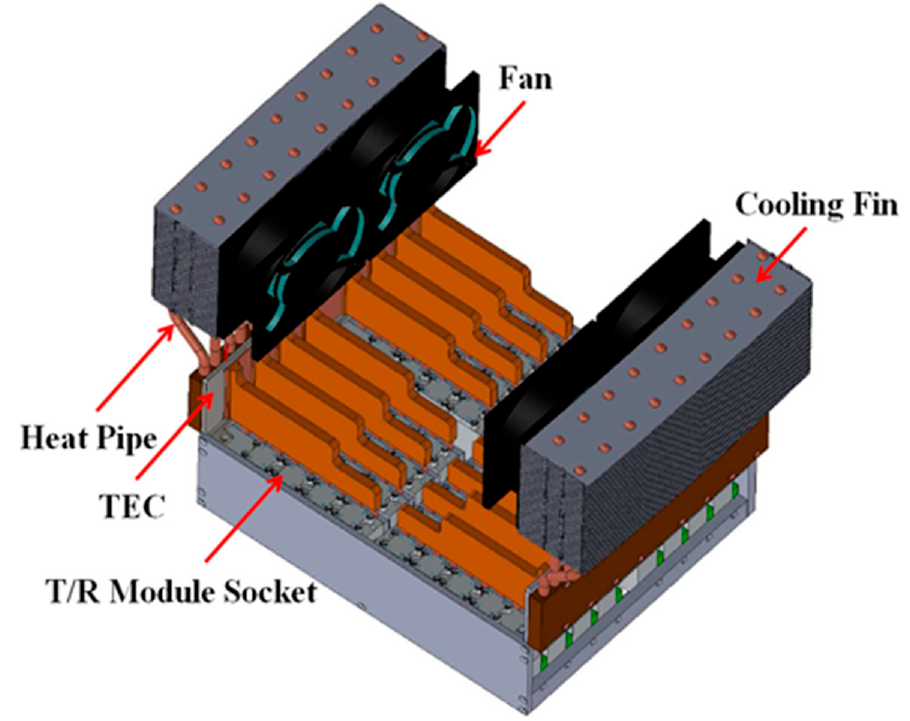
Figure 2. Integrated T/R Module and Heat Dissipation Module.